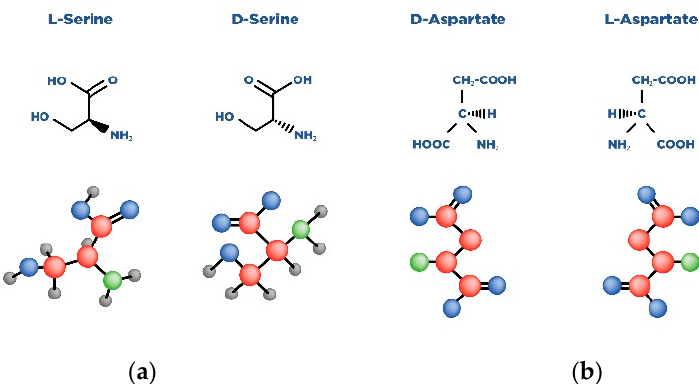
Figure 4. Scheme of L and D isomers of serine ( a ) and aspartate ( b ). L-amino acids are used in the human body as building blocks of proteins and inter- mediate products in biochemical processes [37 ].